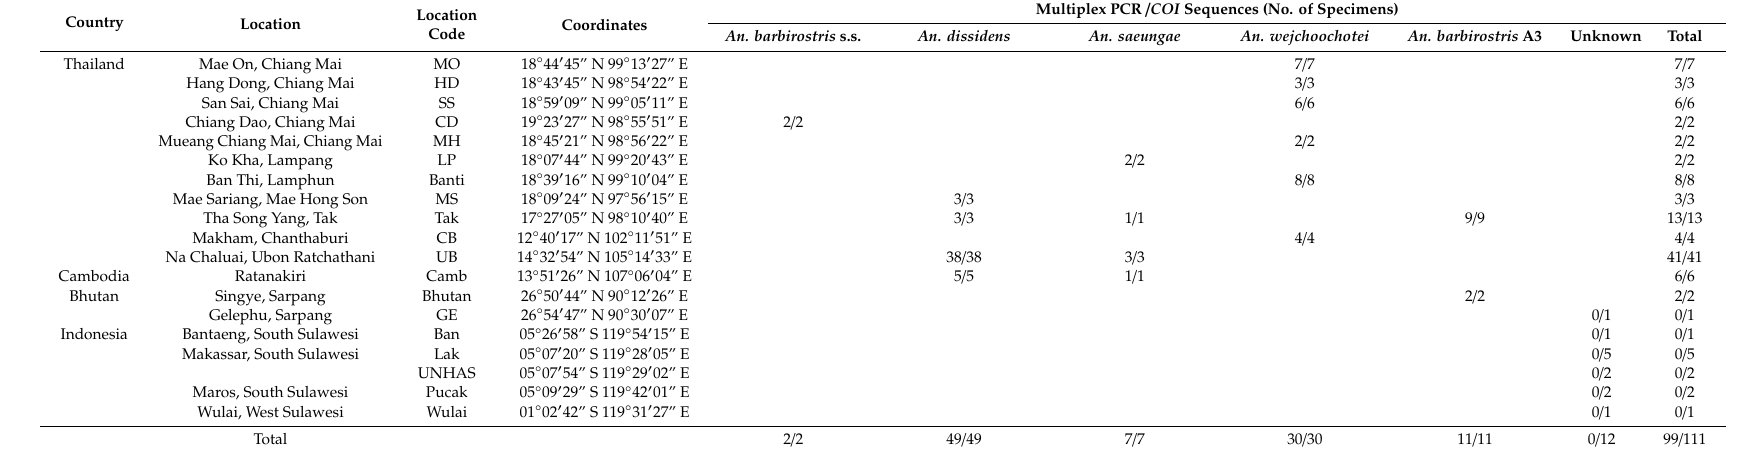
Table 1. Details of collections of An. barbirostris s.l. made in Bhutan, Cambodia, Indonesia and Thailand, and comparison of results from multiplex PCR and mitochondrial cytochrome c oxidase subunit I ( COI )